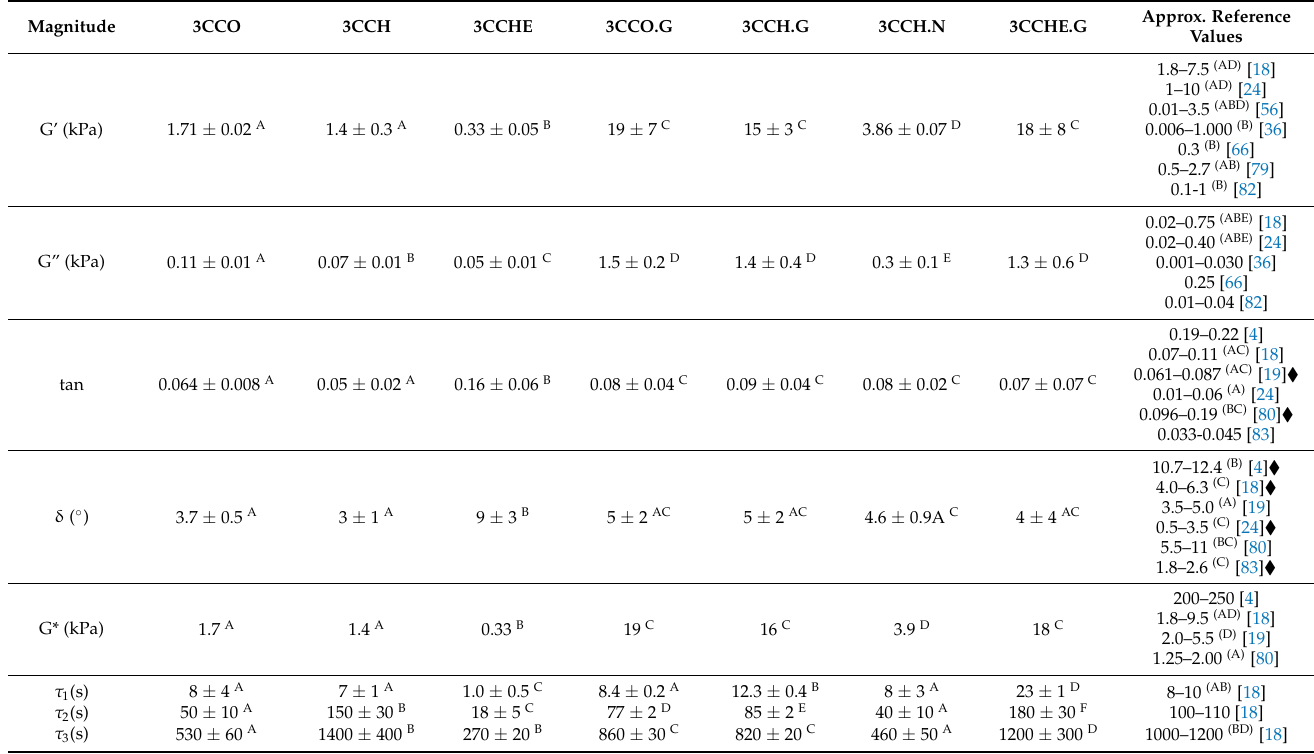
Table 2. Superscript capital letters are used to compare between scaffold values (columns) with matching references values of the literature in the same row.